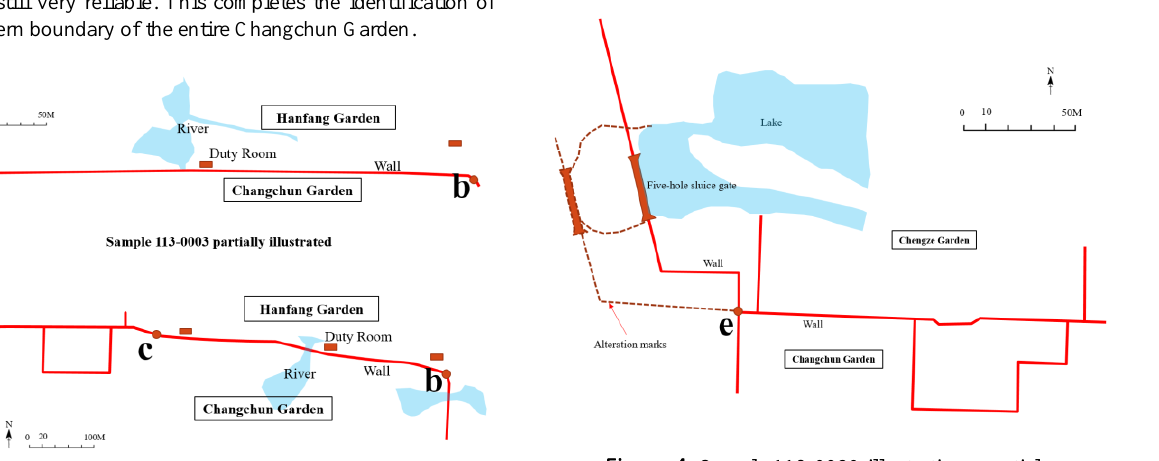
Figure 4. Sample 118-0029 illustration - partial